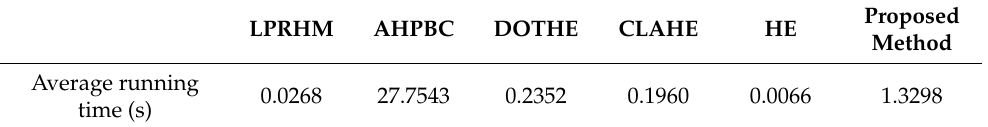
Table 4. Average running